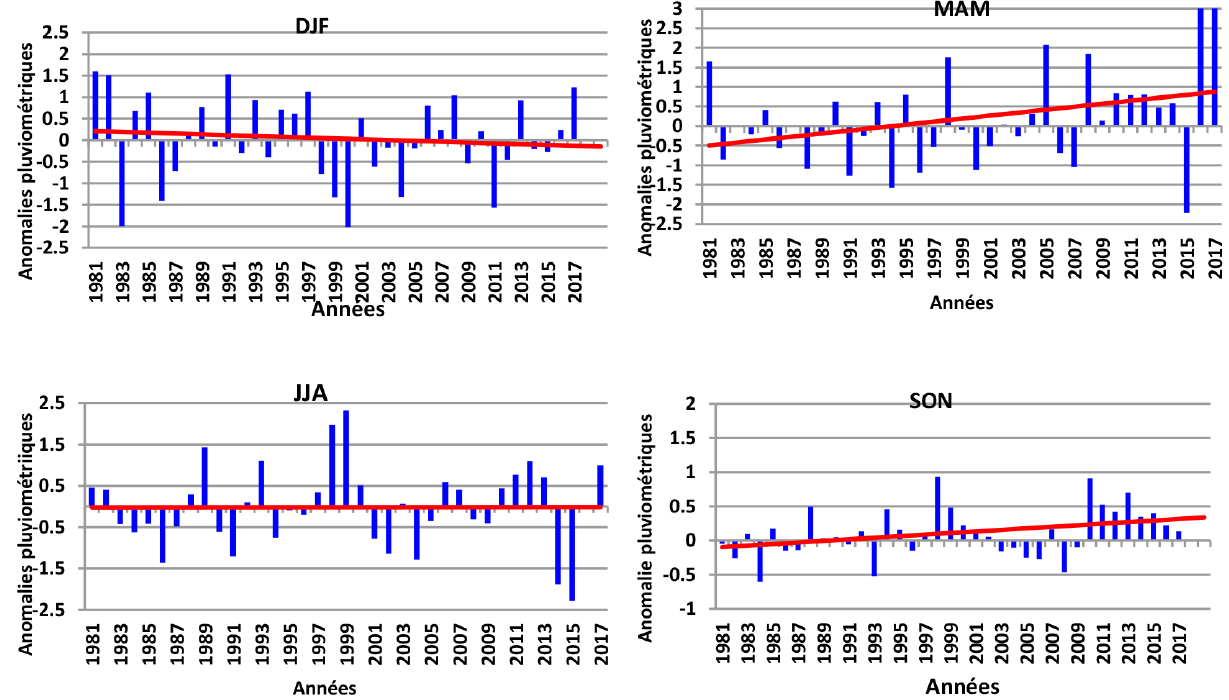
Figure 4. Evolution des séries temporelles associées à chacune des composantes principales cartographiées de 1981 à